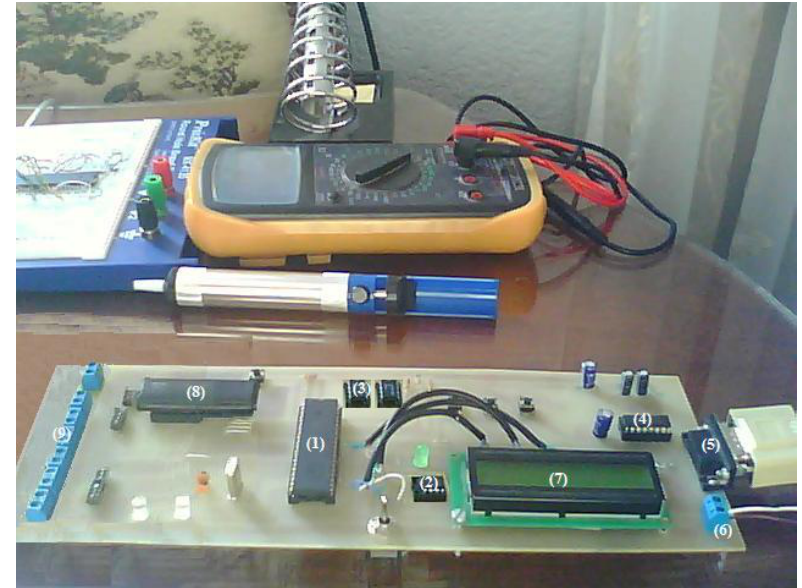
Figure 8. The components of the data-acquisition